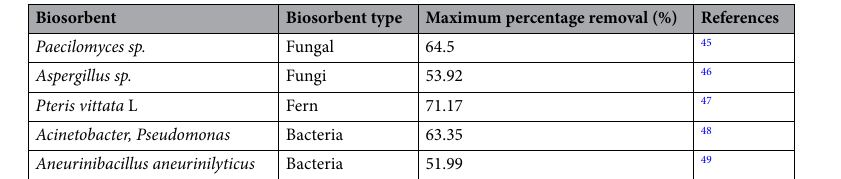
Table 3. Percentage removal of As(III) using different